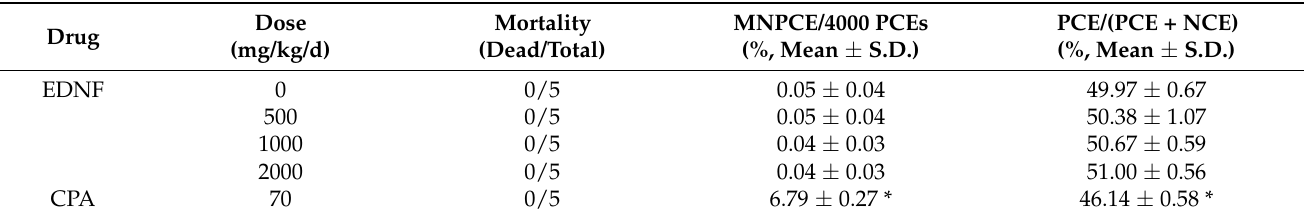
Table 7. The results of the micronucleus test in ICR mice exposed to oral treatment of aqueous extract of dried noni fruits (EDNF).